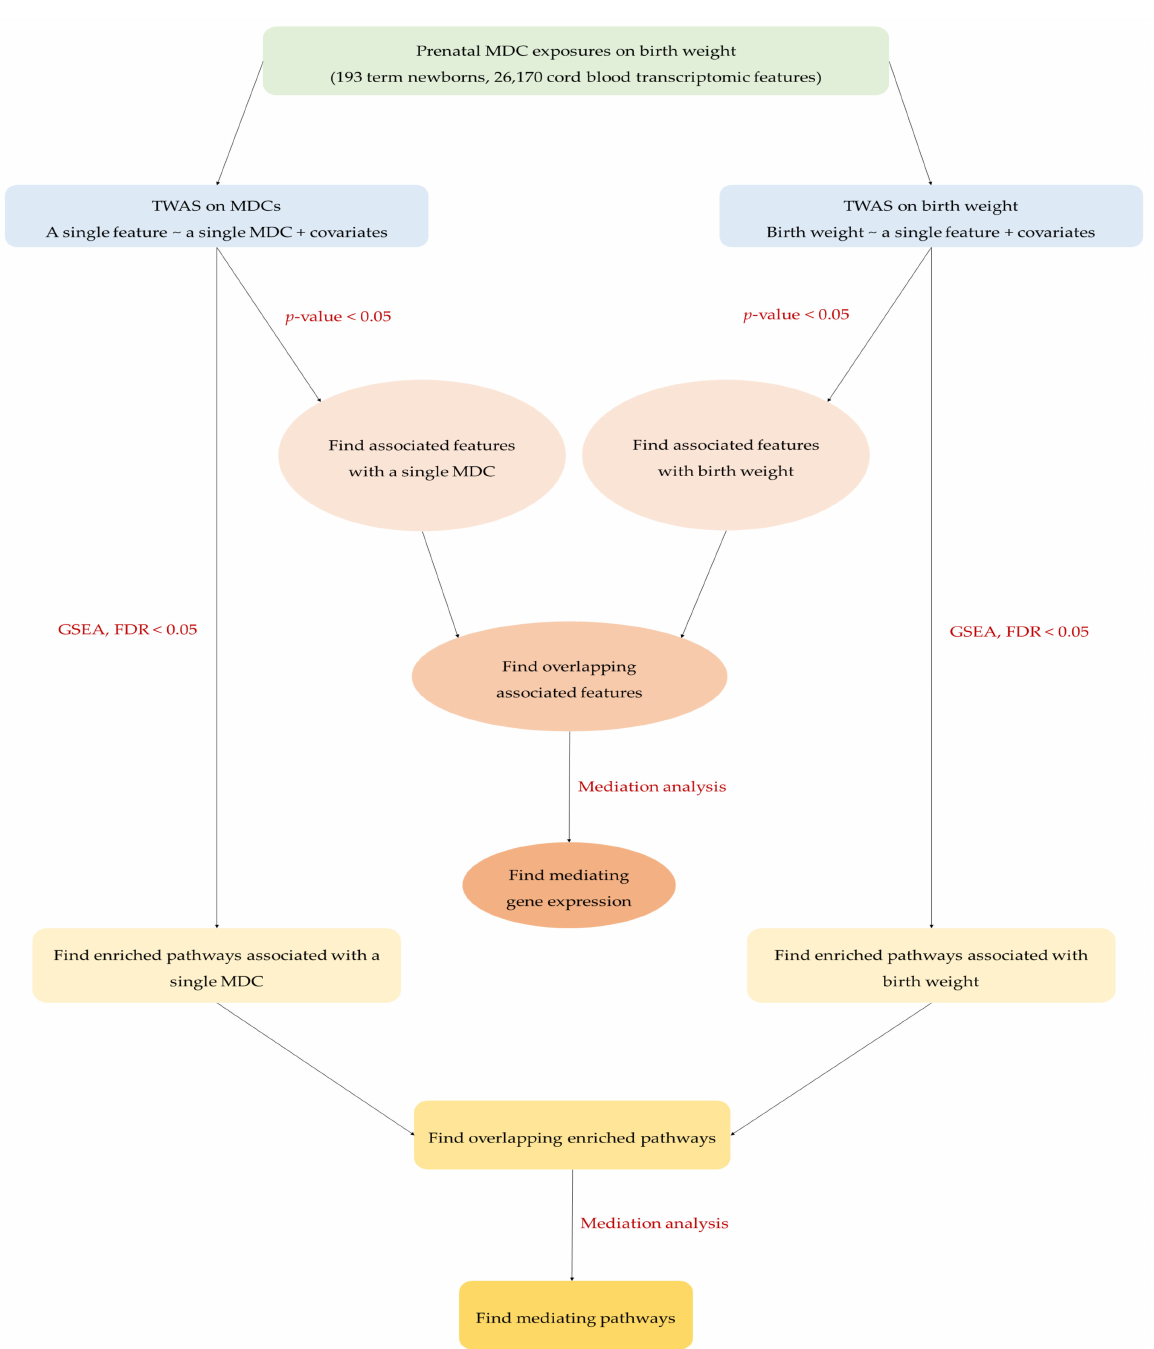
Figure 2. The workflow of meet-in-the-middle approach in the present